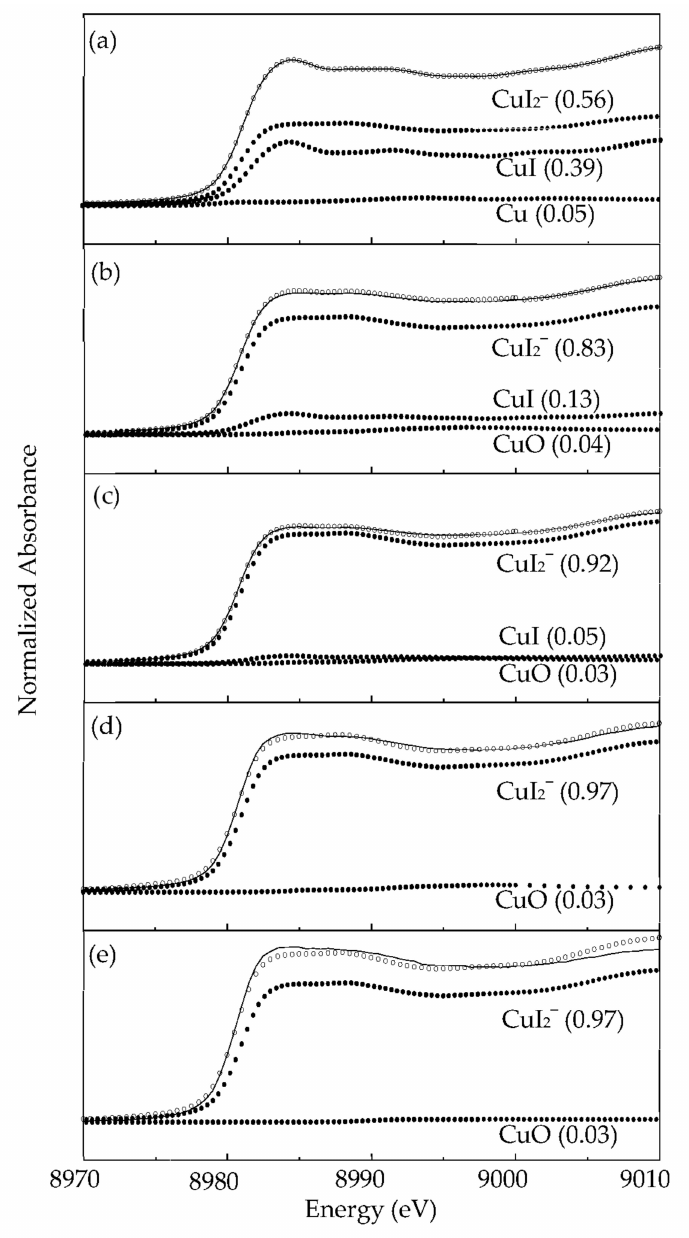
Figure 3. Experimental data (solid line) and the least-squares fit (circles) of in situ XANES spectra of extracted copper in the IL-I at ( a ) 303 ( b ) 343 ( c ) 413 ( d ) 473, and ( e ) 543